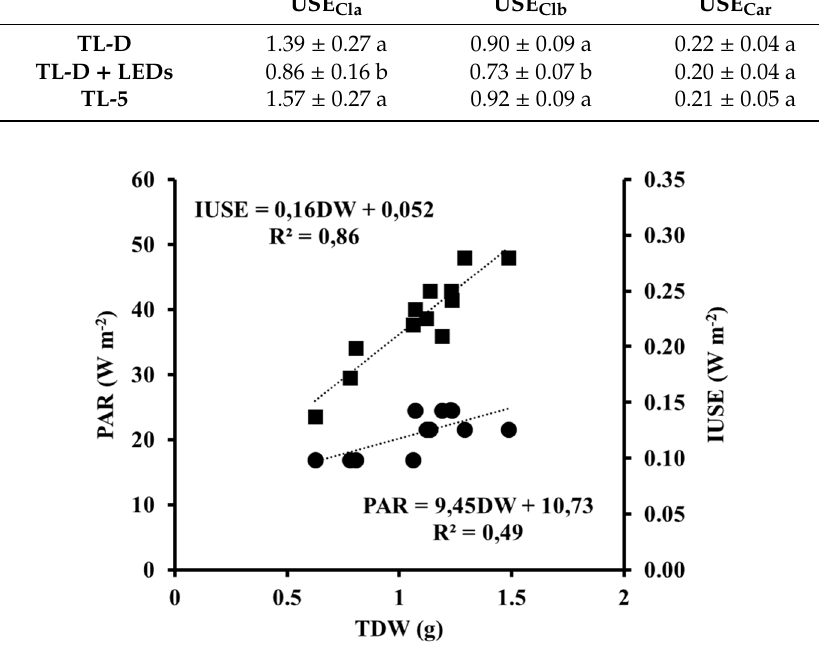
Figure 7. Linear univariant regression model integrated use of spectral energy (IUSE) and photosynthetically active radiation (PAR) with TDW.